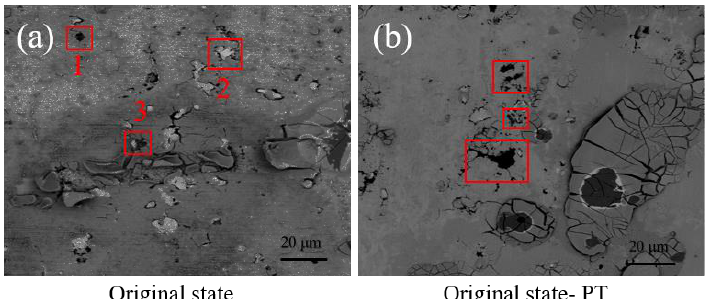
Figure 7. SEM figures of corrosion morphologies at different times. ( a ) Room temperature untreated, E. g. base material. (1) Corrosion pit formed after the precipitated phase falls off; (2) Corrosion pit formed after the precipitated phase has not fallen off, but the surrounding corrosion has begun; (3) Corrosion pit and residual precipitated phase formed by the precipitated phase not being completely peeled off; ( b ) Room temperature untreated, E. g. base material, and corrosion time is prolonged.